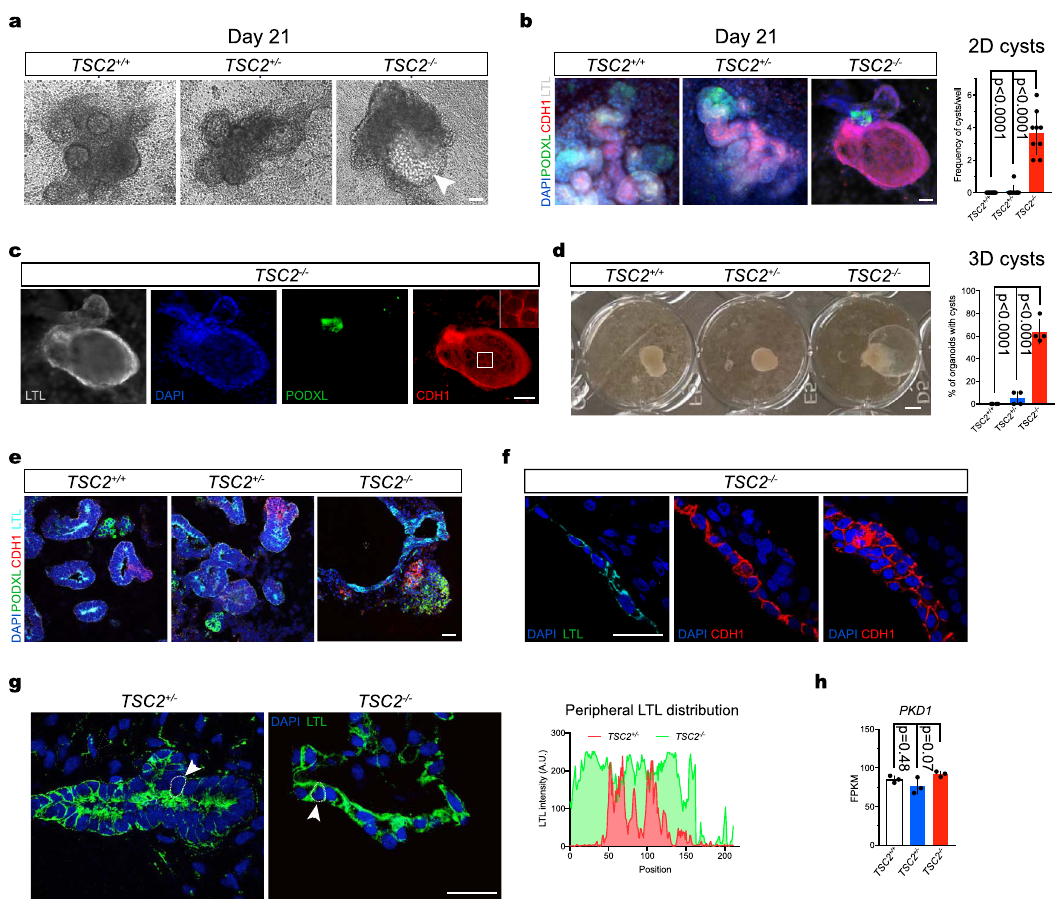
Fig. 4 TSC2 inactivation drives cystogenesis during nephric differentiation. a Representative bright fi eld images of 2D TSC2 − / − hiPSC-derived renal tissues on Day 21 of differentiation. The arrowhead indicates a visible cyst. Twenty independent experiments were performed with similar results. b Immuno fl uorescence image showing 2D nephrons derived from the three hiPSC genotypes, labeled with PODXL1 (glomerulus), LTL (proximal tubule), and CDH1 (distal tubule). Number of cysts per well was quanti fi ed. Bar graphs represent mean ± SD, n = 8 wells from 2 independent experiments. c The cyst framed in the TSC2 − / − nephron micrograph in ( a ) is stained for nephron markers by immuno fl uorescence with inset showing the distal tubule epithelium. Ten independent experiments were performed with similar results. d Bright fi eld image of 3D organoids of the three genotypes showing cystic TSC2 − / − organoids, with quanti fi cation of cyst formation. Bar graphs represent mean ± SD, n = 4 experiments. e Representative confocal sections showing organoid glomeruli, proximal and distal tubule regions as indicated by PODXL1, LTL, and CDH1 staining. A cyst associated with a proximal tubule is shown in the TSC2 − / − organoid section. Twelve independent experiments were performed with similar results. f Anatomical organization of TSC2 − / − organoid cyst lining visualized using confocal imaging, both proximal tubule epithelial cell (PTEC) and distal tubule epithelial cell (DTEC) single-cell layers and DTEC multicellular regions are shown with LTL and CDH1 immuno fl uorescence. Eight independent experiments were performed with similar results. g Representative confocal imaging showing the alterations in polarity observed in PTECs lining TSC2 − / − organoid cysts, compared to TSC2 + / − organoid proximal tubule, using LTL staining. A representative quanti fi cation of LTL signal distribution in the periphery of individual cells is shown. Five independent experiments were performed with similar results. h Expression levels for PKD1 in TSC2 − / − , TSC2 + / + , and TSC2 + / − renal organoids. Bar graphs represent mean ± SD, n = 3 samples for each genotype, fi ve organoids per sample. Gene expression is shown in FPKM values. P values for individual comparisons done using Tukey test in one-way ANOVA analysis are indicated. Scale bars, 50 μ m ( a , b , c , e ), 25 μ m ( f , g ), and 1 mm ( d